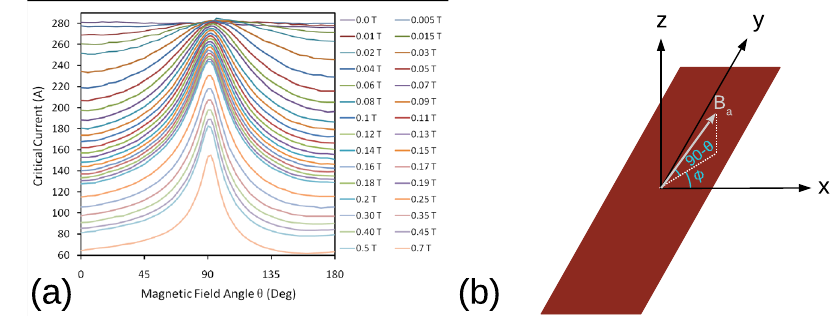
Figure 1. ( a ) Experimental I c ( B , θ) data used as input J c for modeling, derived from 8 . Data was measured at 77.5 K in magnetic fields up to 0.7 T from a Superpower SF12050CF wire. ( b ) Sketch of I c ( B , θ , φ) showing the angle θ along with angle φ as the angle between the x axis and the projection of the applied magnetic field to the xy plane.